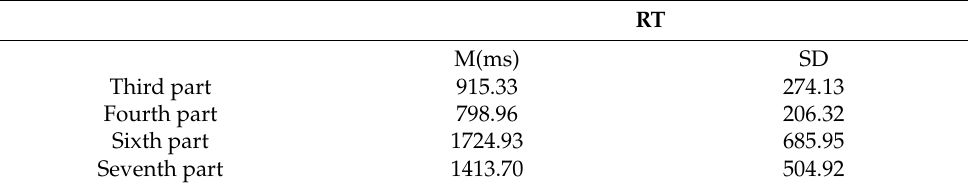
Table 5. The mean RT and SD in different parts of the joint discrimination